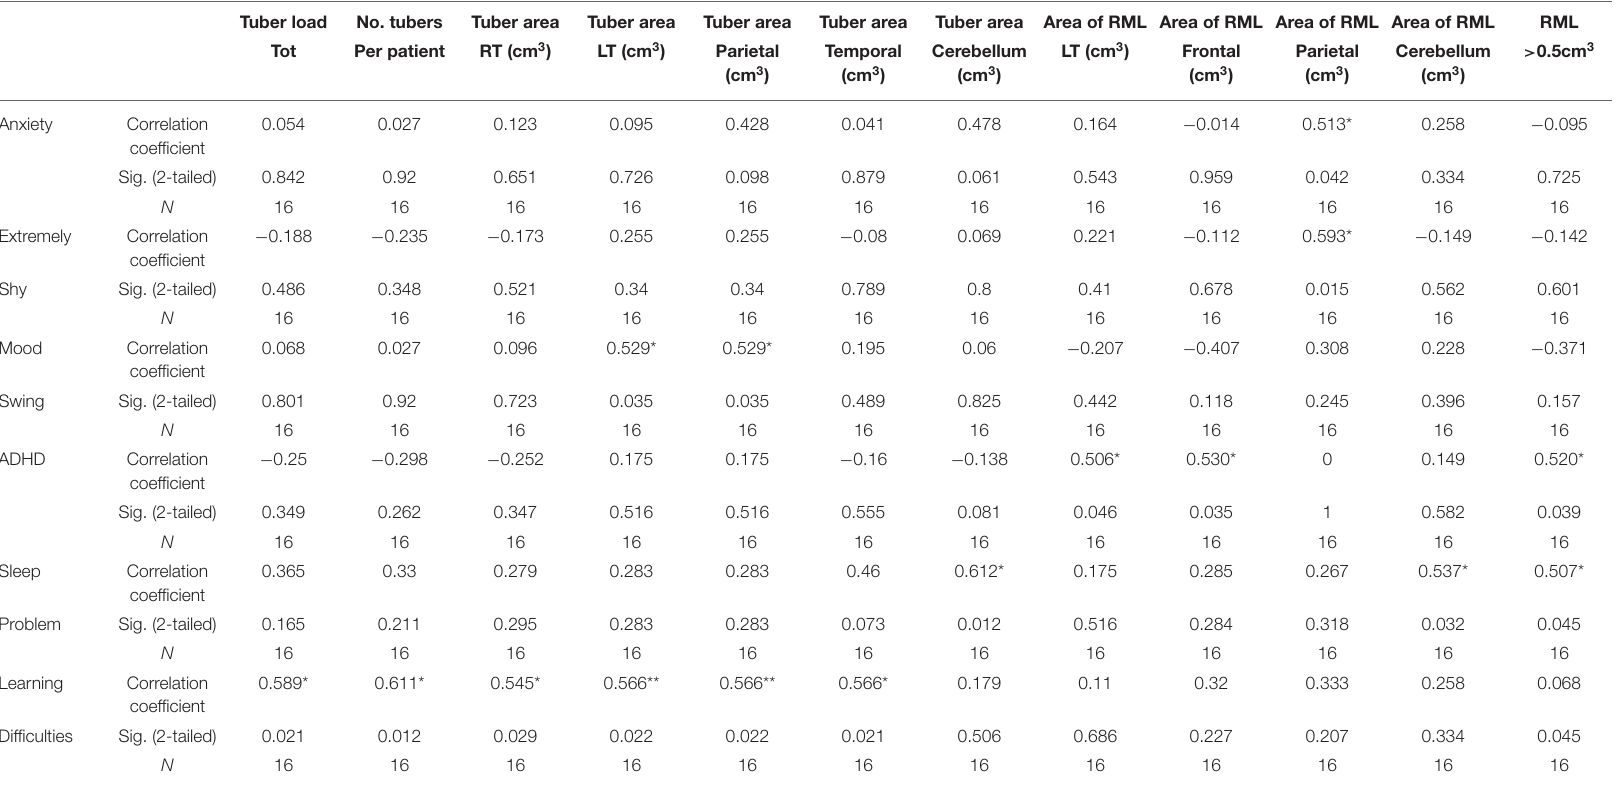
TABLE 3 | Correlations of tubers and radial migration lines with scores on the TAND